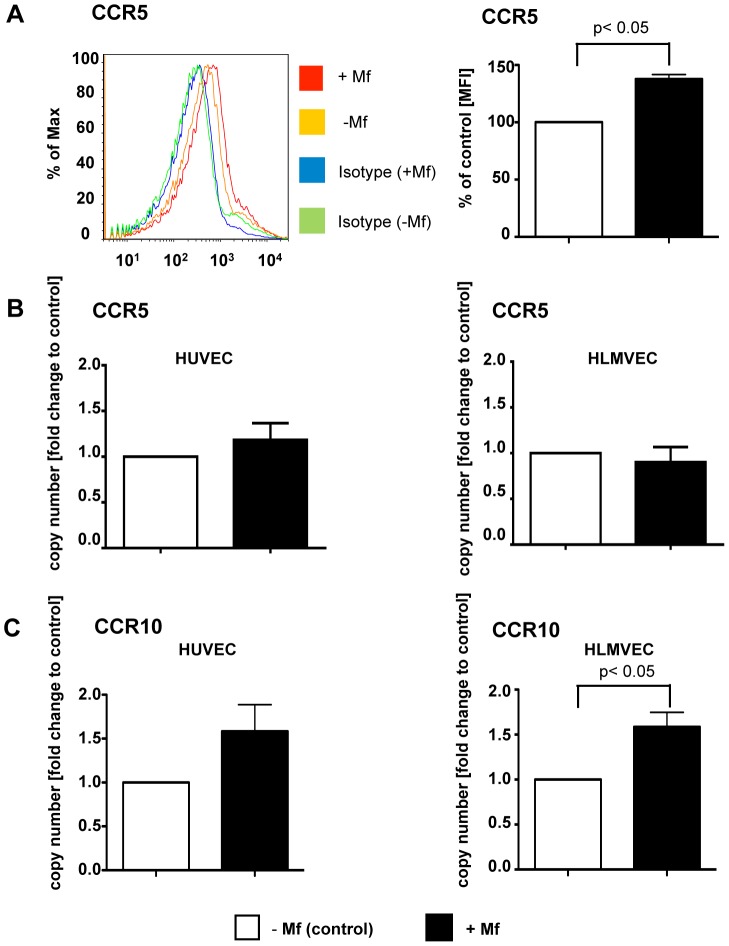
CCR5 and CCR10 are upregulated in vascular EC by live Mf presence.HUVEC or HLMVEC were cultured with live B. malayi Mf for 24 hours prior to isolation of total EC RNA and flow cytometric analysis. CCR5 surface expression was measured by flow cytometry of HUVEC incubated with or without Mf and labeled with isotype control or anti-human CCR5. The FACS plot is presented and a bar graph presenting mean fluorescence intensity (MFI) of CCR5 in HUVEC ± Mf (a). Real time quantitative RT-PCR was used to analyse mRNA expression of CCR5 (b) and CCR10 (c) in HUVEC and HLMVEC. Data are shown as the mean and standard deviation of three independent experiments and analysed by Students t-test.